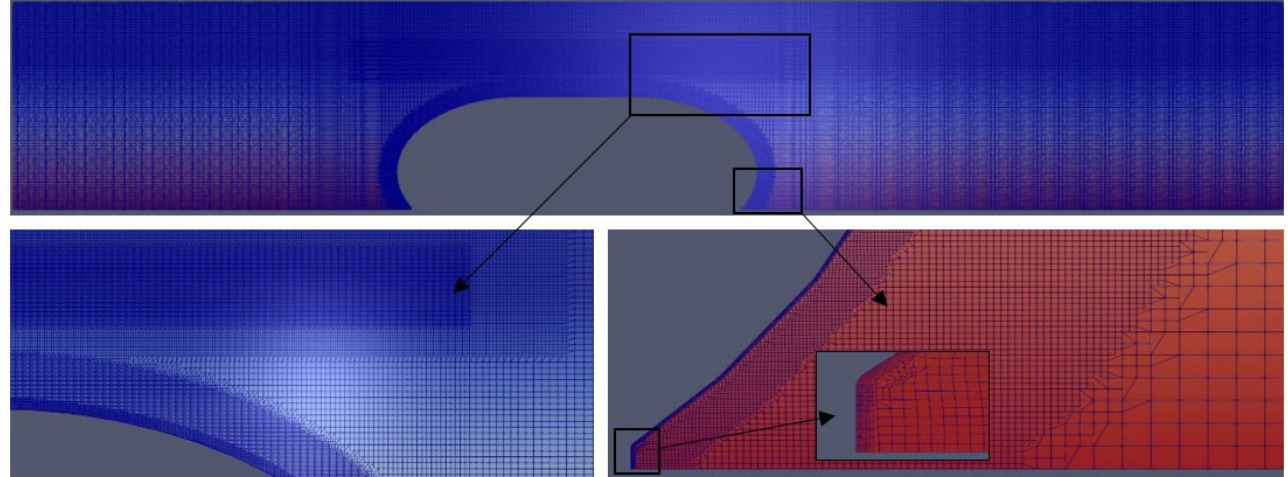
Figure 2. Cell grid of the OpenFOAM model.